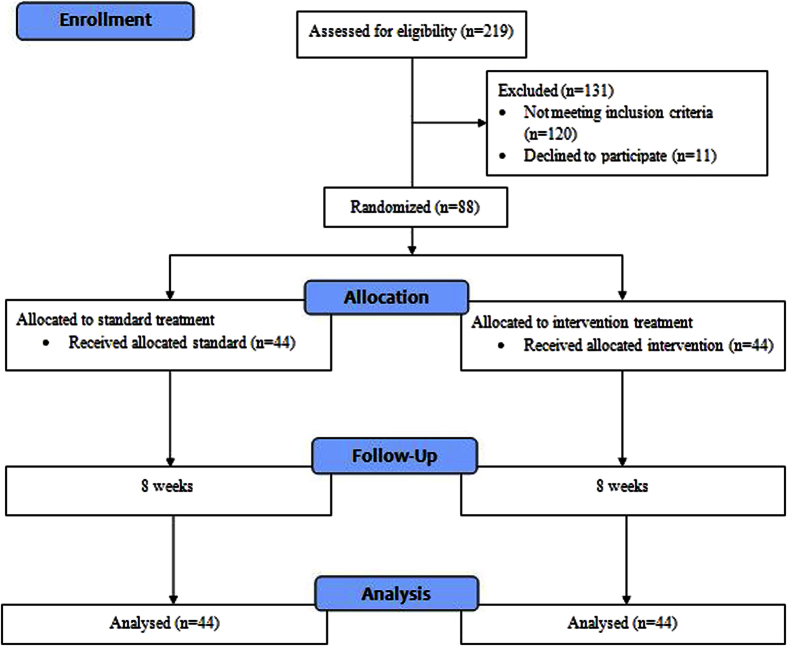
Study flow chart.